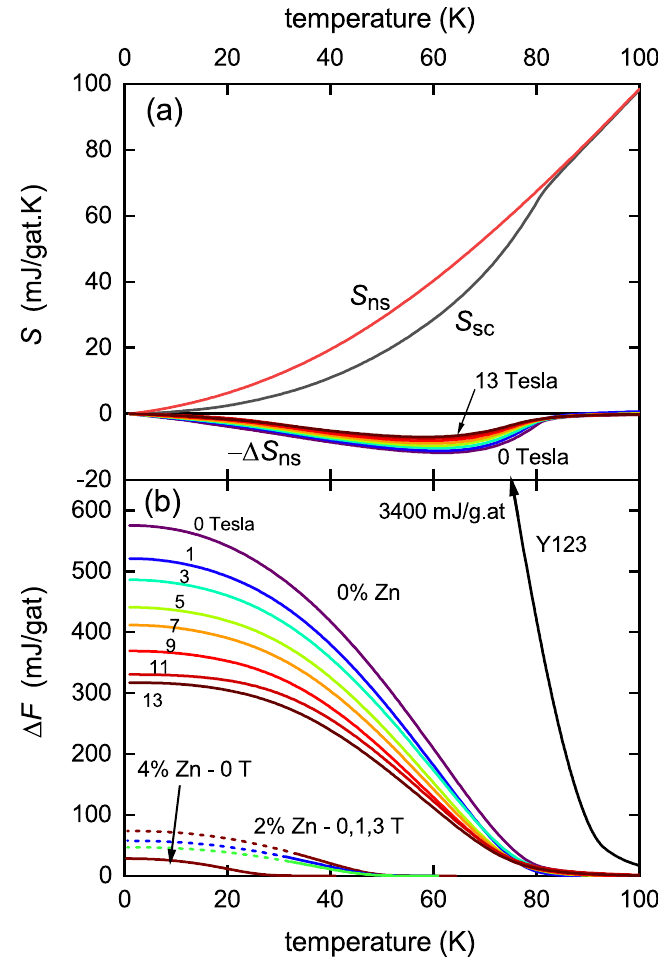
Figure 4. ( a ) The normal-state entropy, S n ( T ) , obtained by integrating the black dashed curve in Fig. 1b and the measured entropy, S s ( T ) , for pure Y124 in zero field. The condensation entropy, � S ns shown underneath for µ 0 H = 0, 1, 3, 5, 7, 9, 11 and 13 T colour-coded as in ( b ). ( b ) The T -dependence of the F n F s for pure Y124 obtained by integrating � S ns ( T ) from above T c for each condensation free energy (cid:31) F ns = − field as annotated. Below these are shown the condensation energy for the 2% Zn and 4% Zn samples showing a rapid suppression with scattering and applied field. The condensation energy for fully-oxygenated Y123 is also shown and is much